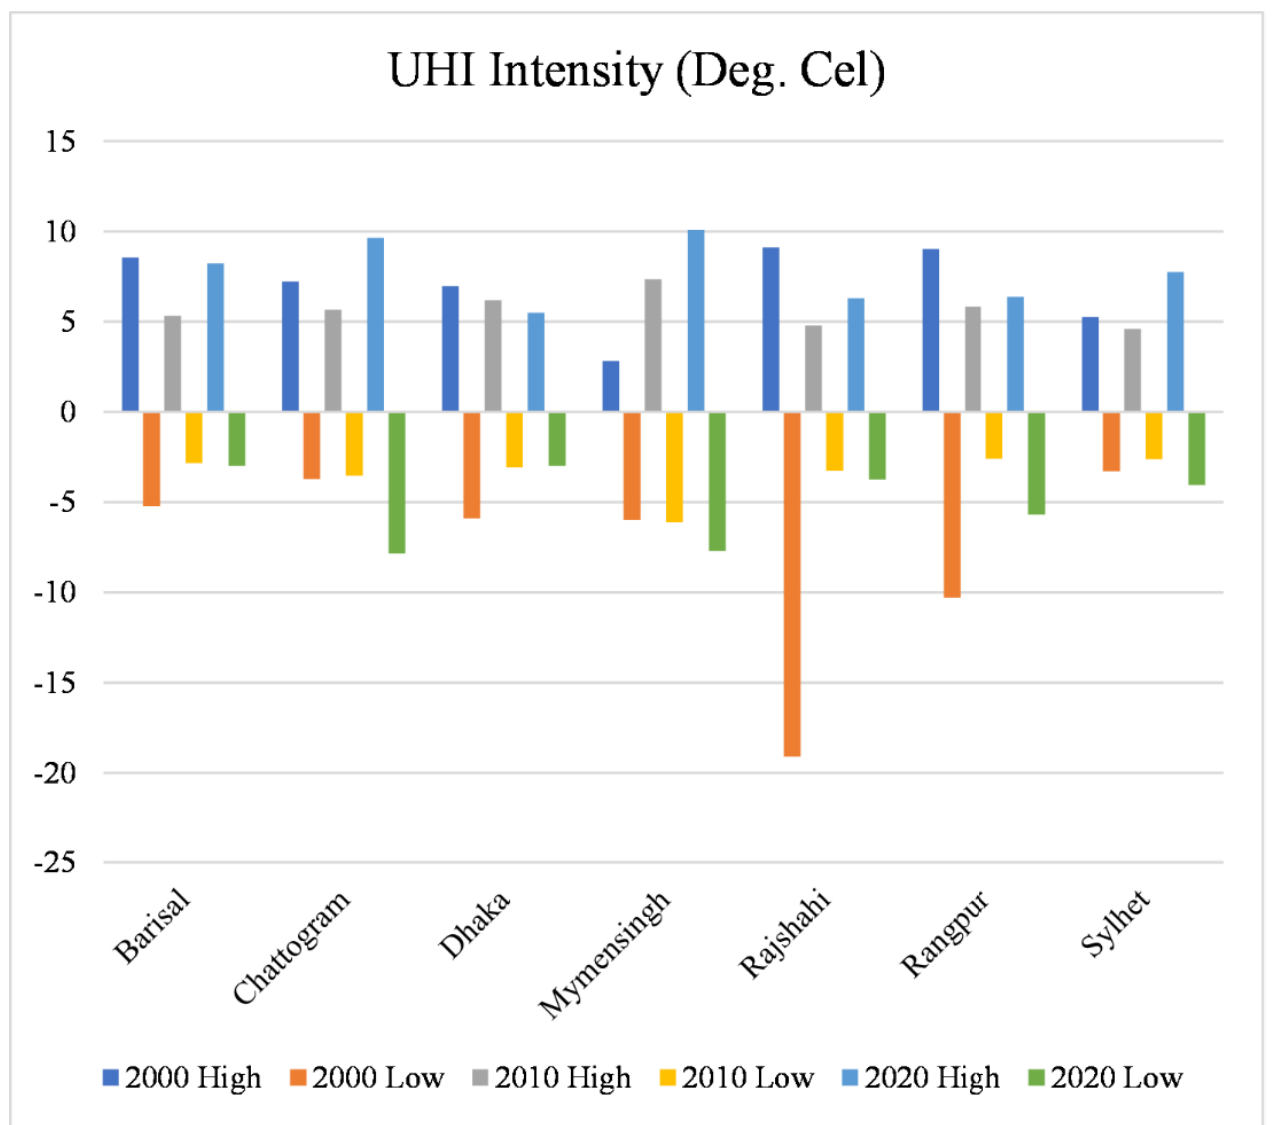
Figure 8. UHI intensity for seven major districts of Bangladesh during 2000 – 2020.